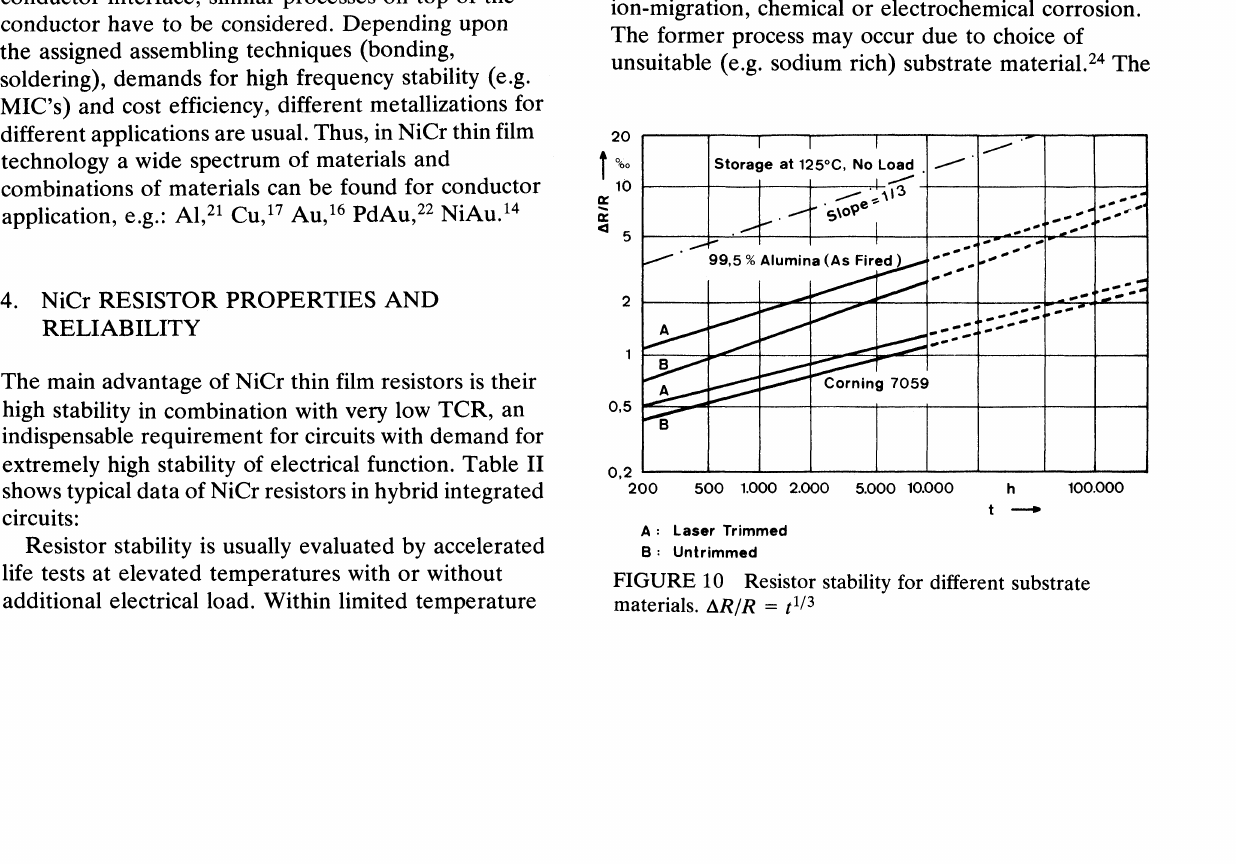
FIGURE 10 Resistor stability for different substrate materials,